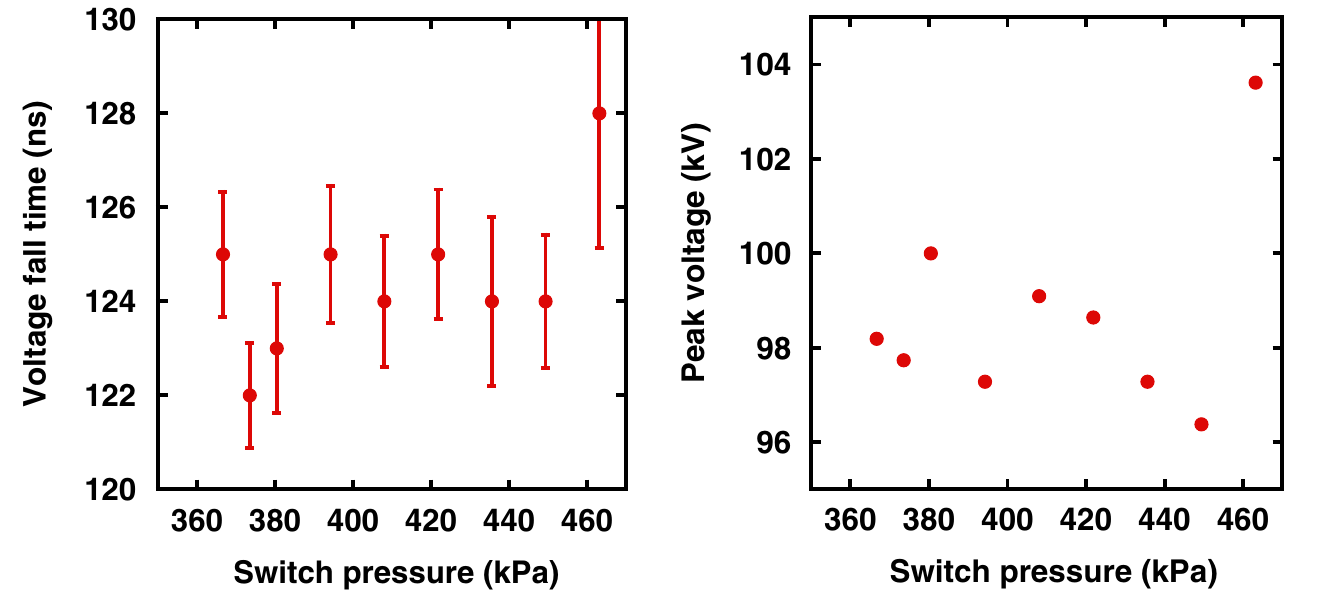
FIG. 17. (Color) Average pulse fall time as a function of switch pressure. The error bars represent the shot to shot statistical variation ( 1 (cid:2) ).